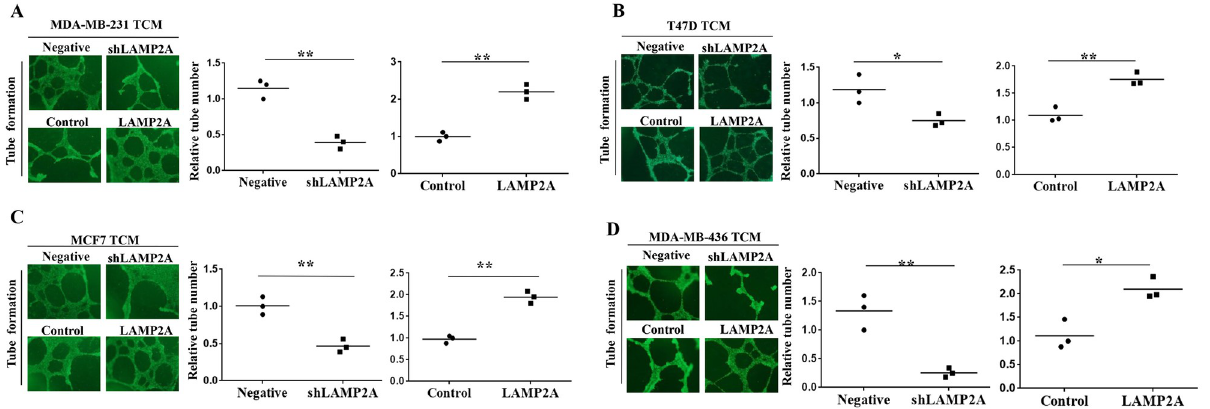
Fig 2. Chaperone-mediated autophagy promotes angiogenesis in vitro . (A) to (D) TCM was collected from different breast cancer cells after LAMP2A knockdown or overexpression, cocultured with HUVECs for 12 h, and then tubule numbers were counted via tube formation assay. � P < 0.05 and �� P < 0.01. Data are representative of three independent